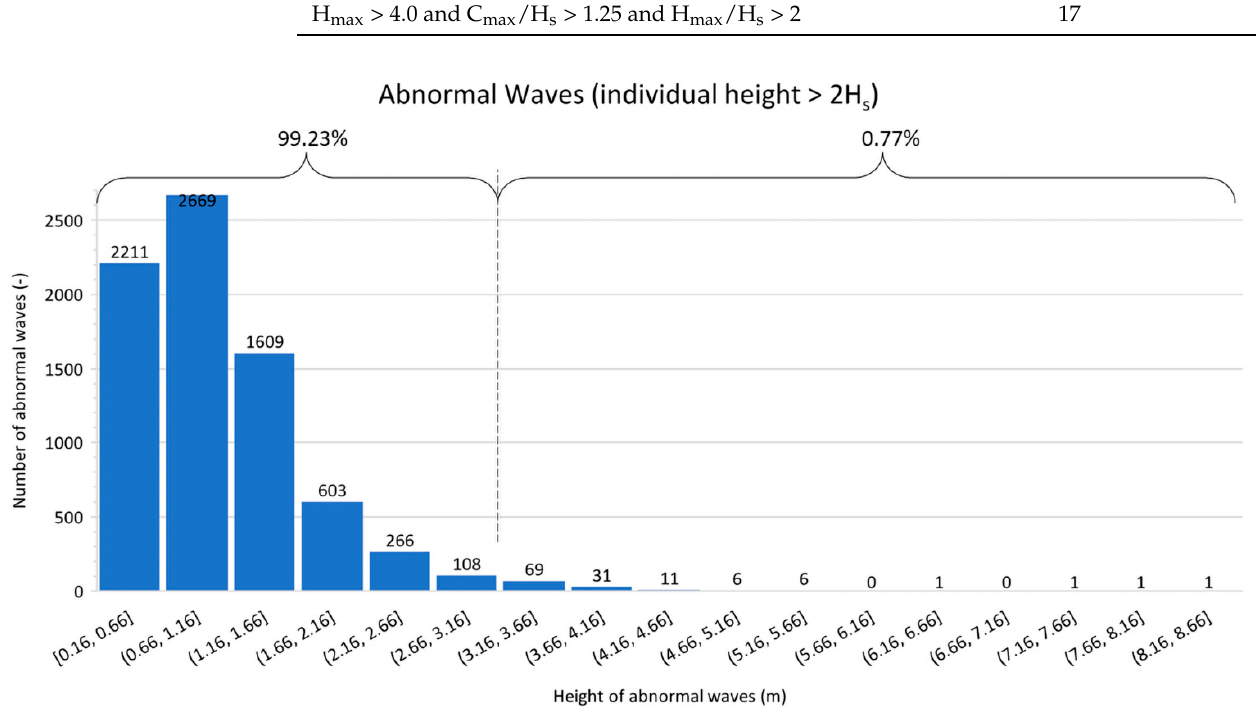
Figure 2. A histogram showing the number of abnormal waves per height bin that were found by the Tampa Bay Waverider buoy. Table 1. The different definitions of rogue wave events and the number of waves that met those criteria that were found in the dataset recorded by the CDIP Waverider buoy near Egmont Key in 2015–2019. Hmax is the measured maximum wave height (from maximum surface elevation), H s is the significant wave height and C max is the maximum crest height.